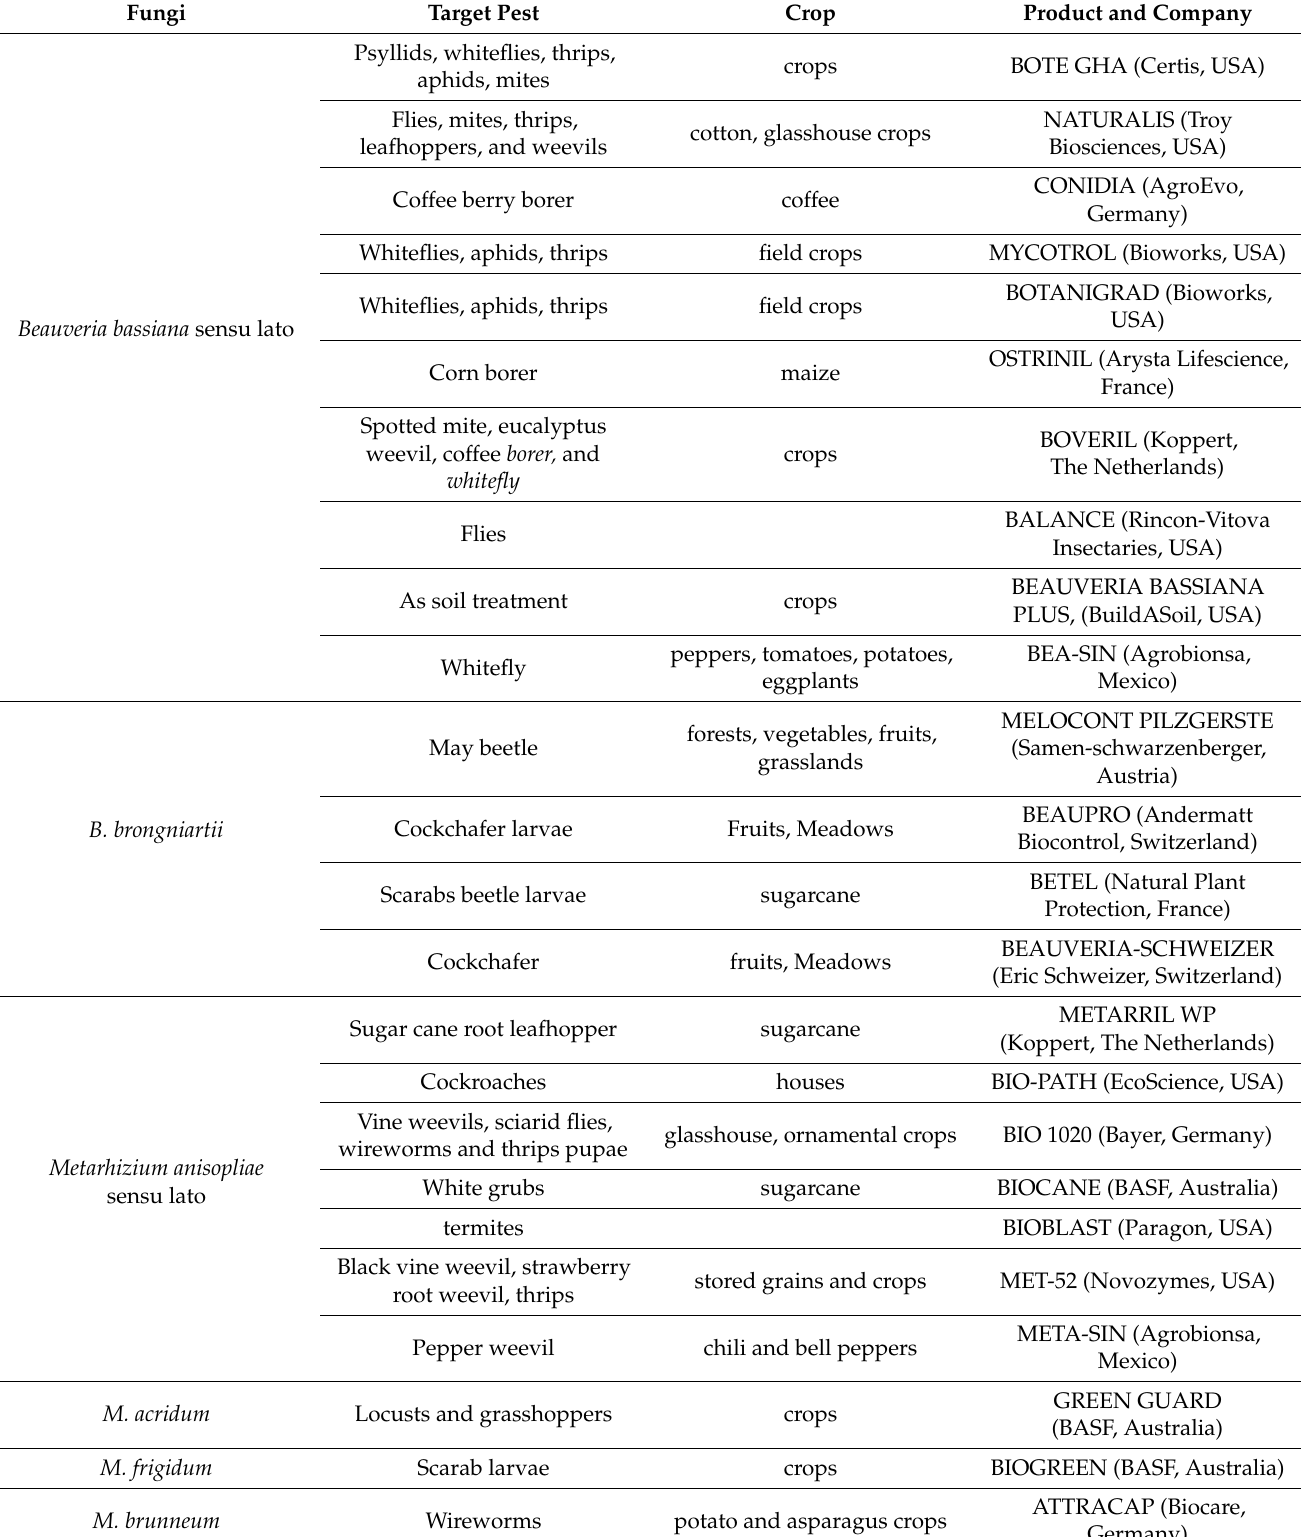
Table 2. Examples of common commercially available entomopathogenic fungi (EPF) and their target insect groups.